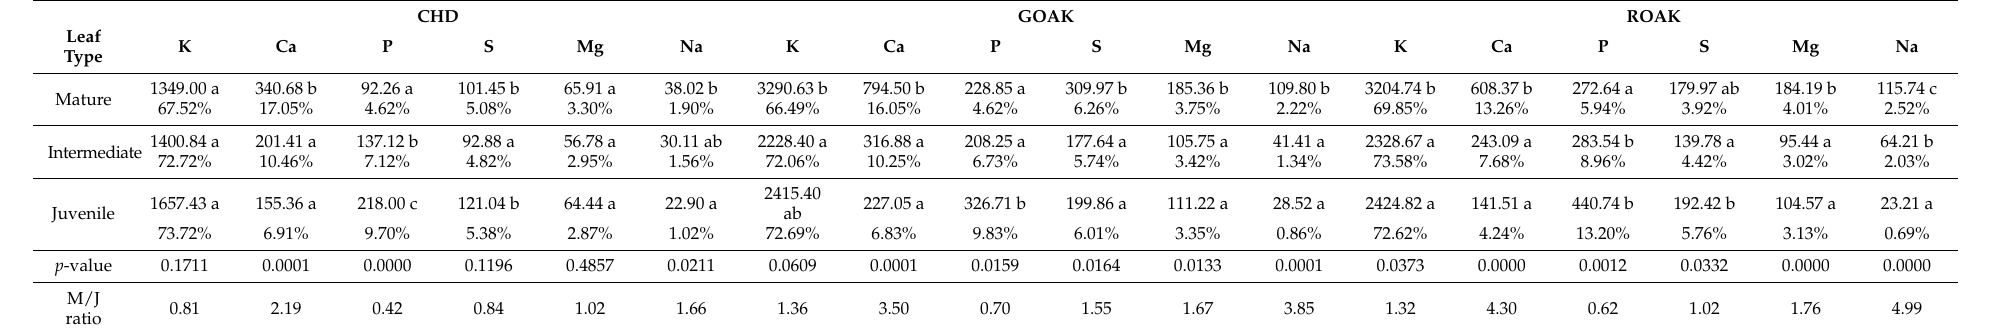
Table 2. Analysis at the cultivar level (CHD, GOAK, and ROAK) and by leaf type of the macronutrients studied in this trial (ppm). Percentages to the proportion of each nutrient in each type of leaf. Data are means of 12 replicates with different letters for each column indicating significant differences ( p -value < 0.01) as determined by LSD multiple comparisons test in different types of leaves analyzed.